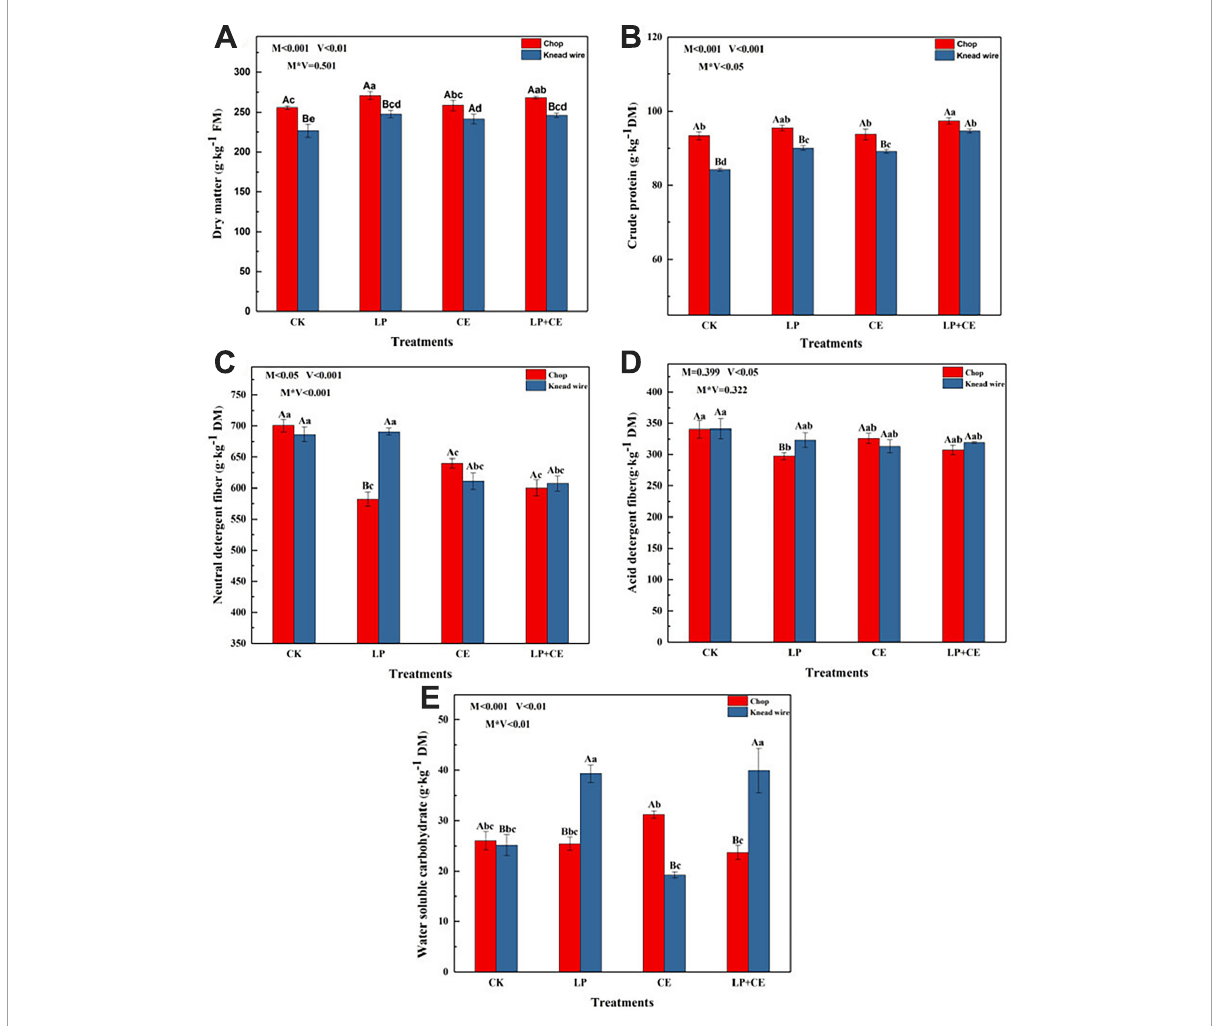
FIGURE1 Effects of cutting methods and fermentation additives on (A) DM, (B) CP, (C) NDF, (D) ADF, and (E) WSC of Saccharum arundinaceum after 60 day of ensiling. CK, control; LP, Lactobacillus plantarum ; CE, cellulase; LP + CE, L. plantarum plus cellulase. Significant differences ( P < 0.05) between the same additive treatments are indicated by capital letters, and significant differences ( P < 0.05) among different treatments are indicated by lowercase letters. DM, dry matter; FM, fresh matter; M, cutting methods; V, additive; V*M, the interaction between additive and cutting methods.